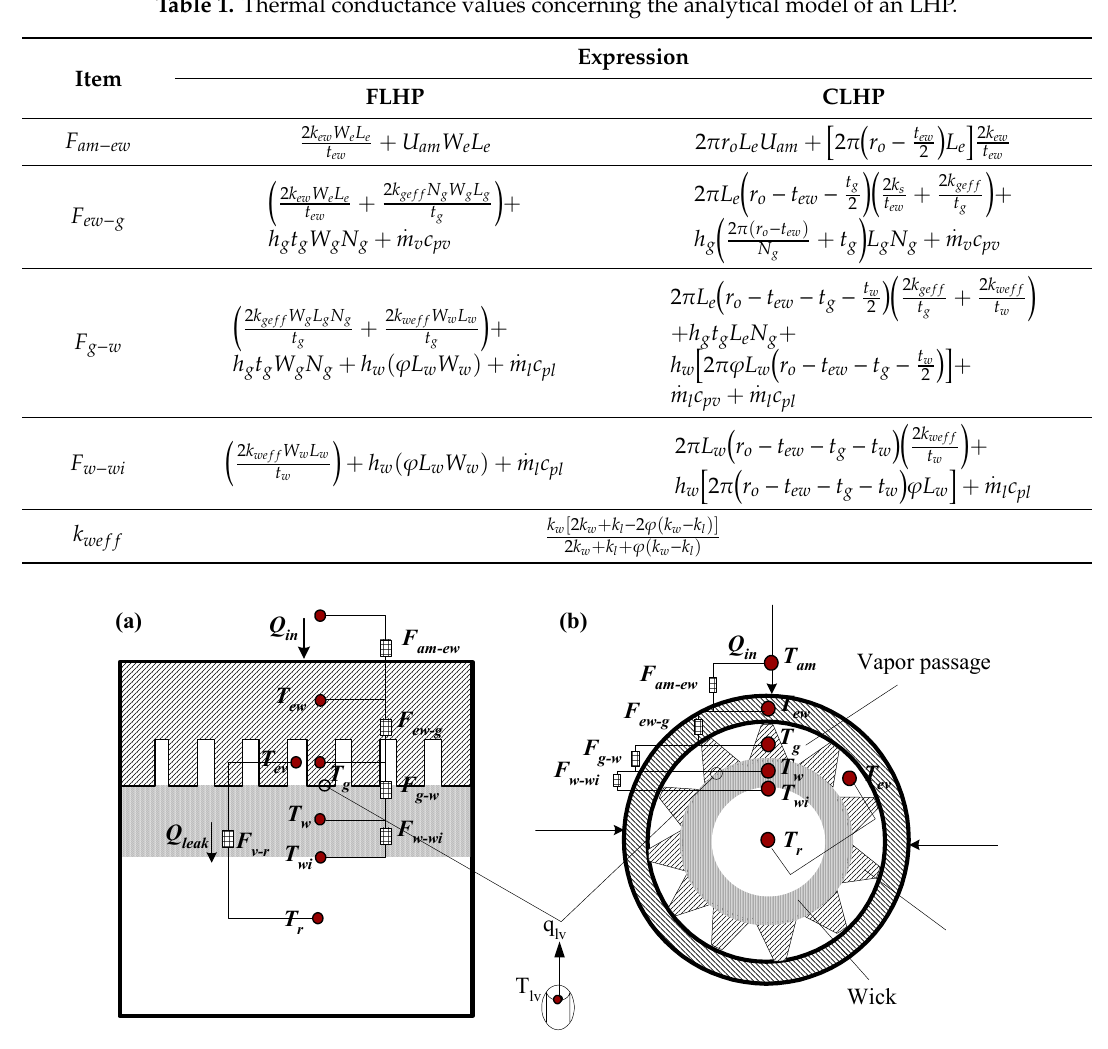
Figure 3. Schematic of FLHP and CLHP for cross-section A–A—( a ) FLHP; ( b ) CLHP.